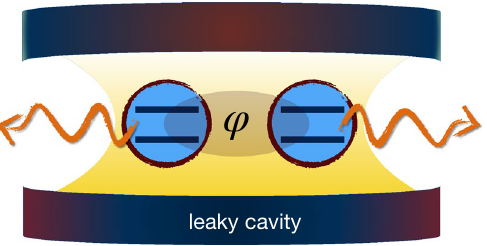
Figure 3. Illustration of two separated qubits both interacting with a zero-temperature common dissipative cavity. The initial state of the qubits is such that a relative phase parameter ϕ appears between the two-qubit basis states. This figure was created using Keynote, version 10.3.9 (7029.9.8), URL: https:// apps. apple. com/ it/ app/ keyno te/ id409 183694? mt=